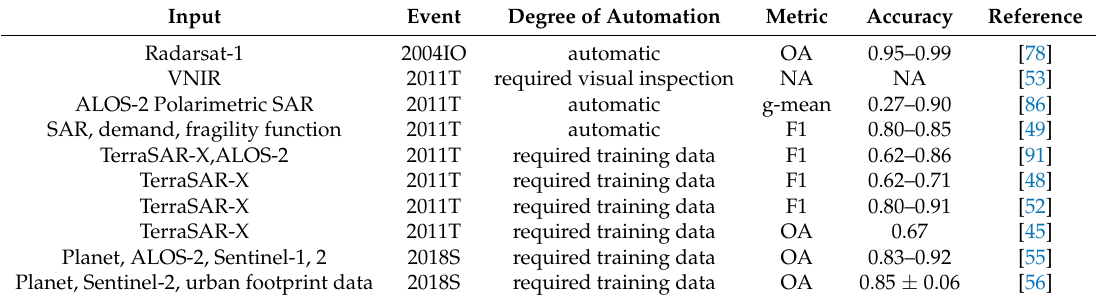
Table 3. Summary of the studies related to tsunami damage identification using machine learning algorithms. Abbreviations are as follows: 2004IO = 2004 Indian Ocean tsunami, 2011T = 2011 Tohoku tsunami, OA = overall accuracy, NA = not